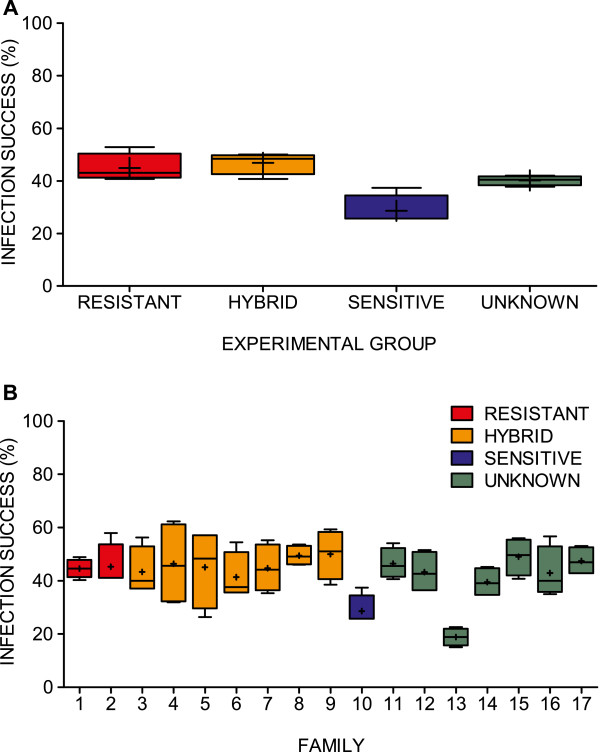
Infection success variability in the common-garden experiment. Ratios (%) between the numbers of L. salmonis individuals sampled at termination day and the initial numbers of copepodids at infection, when separated by the four experimental groups (A), and by the 17 families (B). Data presented from the four replicate tanks, where coloured boxes represents the 25-75% quartile, whiskers at min - max, line at median and (+) at mean values.